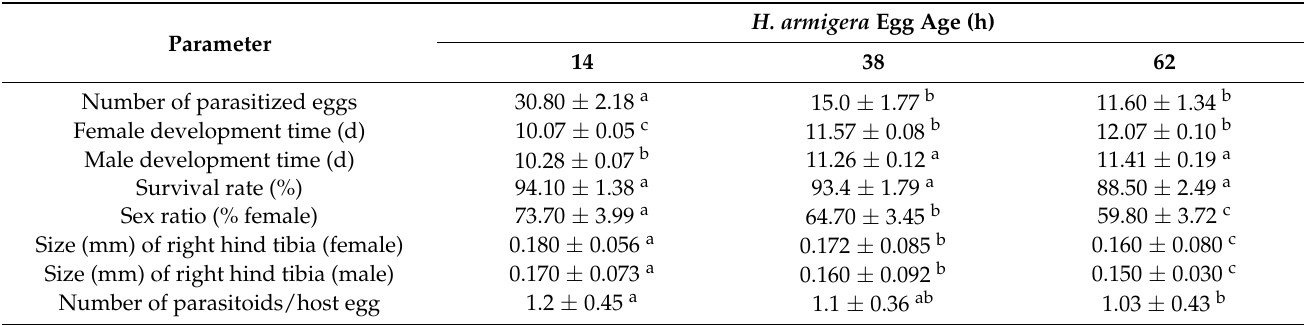
Table 1. Parasitism and biological parameters of T. euproctidis emerging from H. armigera eggs of different ages. Data represent mean ( ± SE)